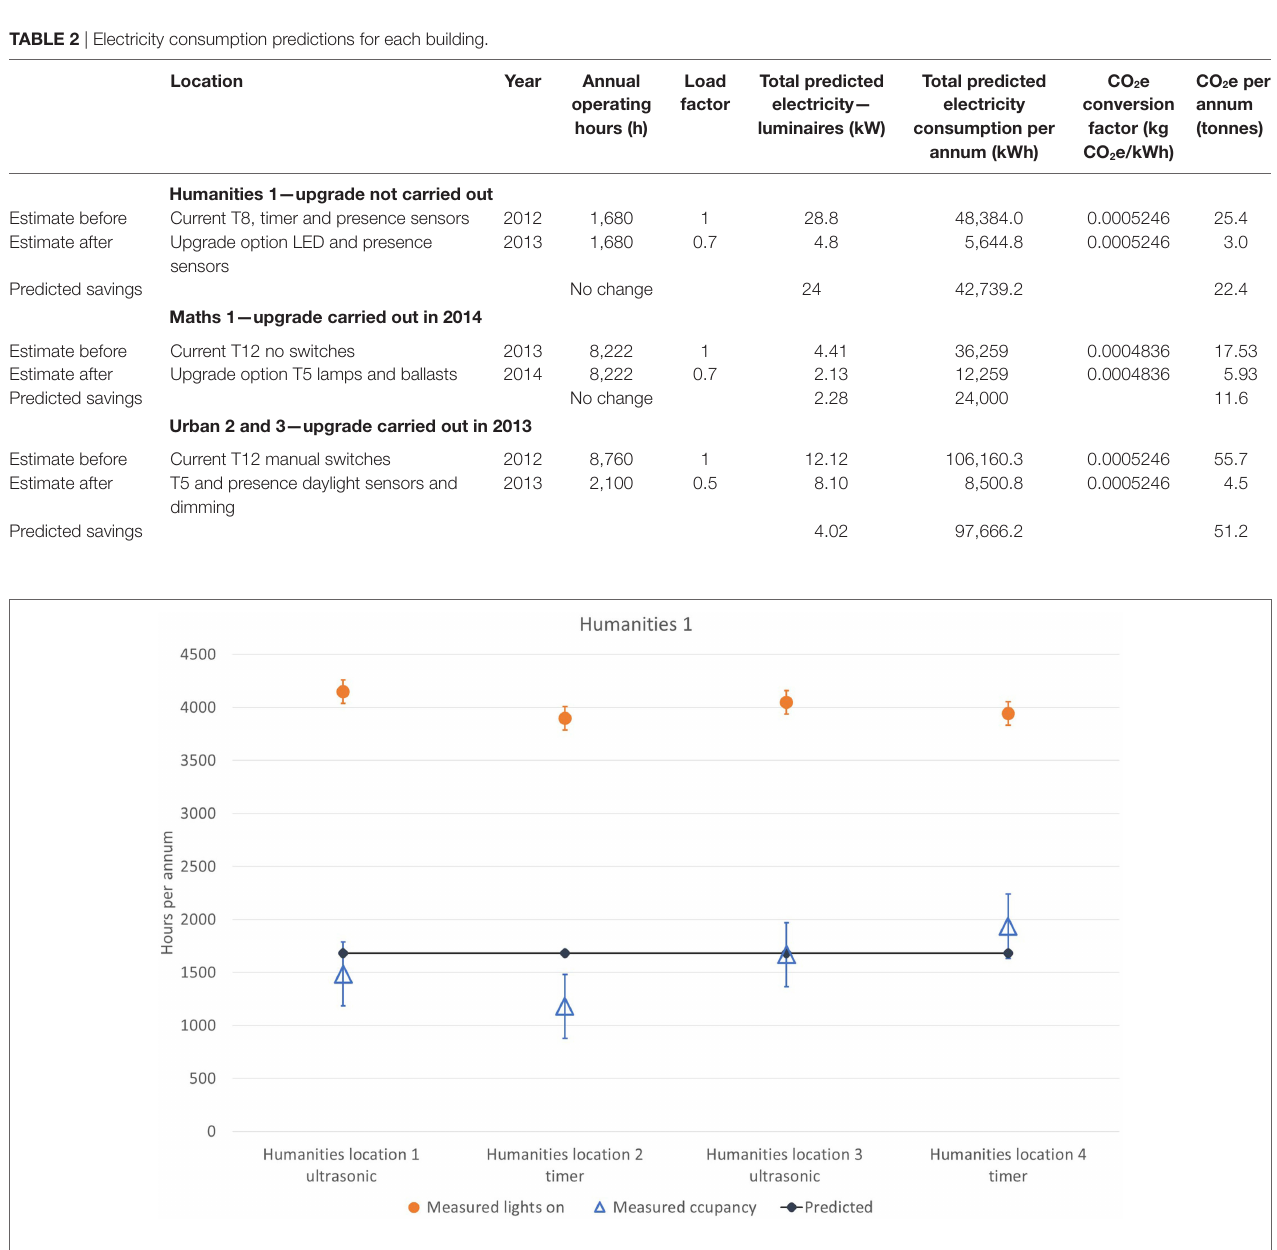
FigUre 2 | Predicted operational hours and measured hours per annum in the Humanities 1 Building.